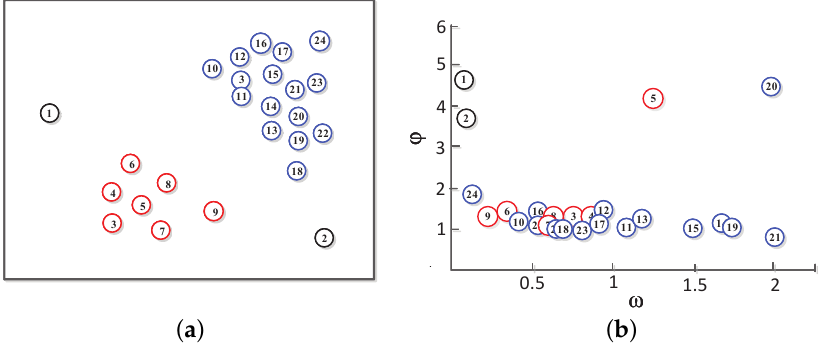
Figure 3. Two-dimensional data point model diagram: ( a ) Data distribution; ( b ) Decision